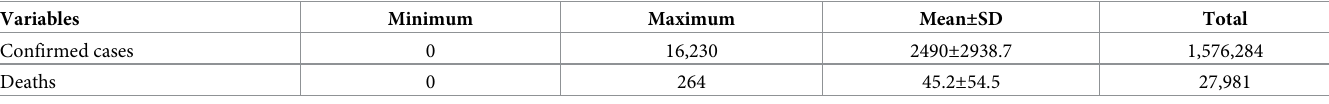
Table 1. Summary of COVID-19 confirmed cases and deaths count during March 08- November 30, 2021.